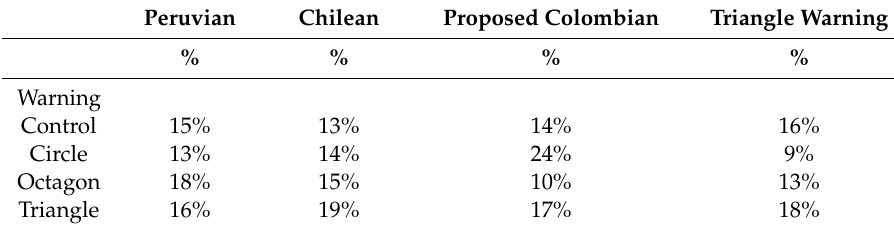
Table A7. Previous exposure to